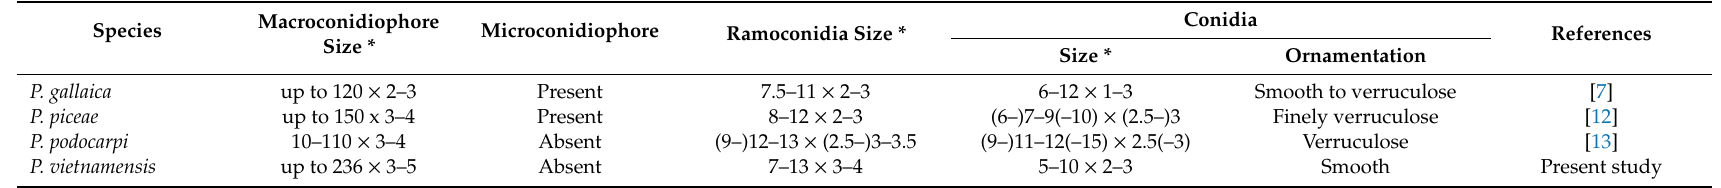
Table 3. Key morphological features distinguishing the accepted Pseudopenidiella